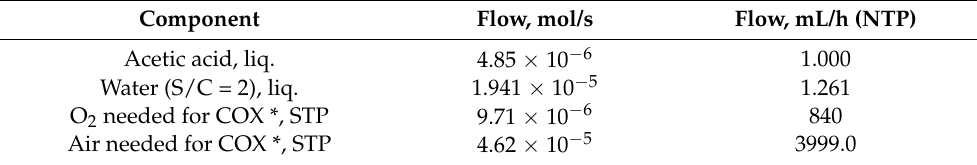
Table 1. Input values used for equilibrium analysis in Aspen flows used for all reactants. Component Flow, mol/s Component